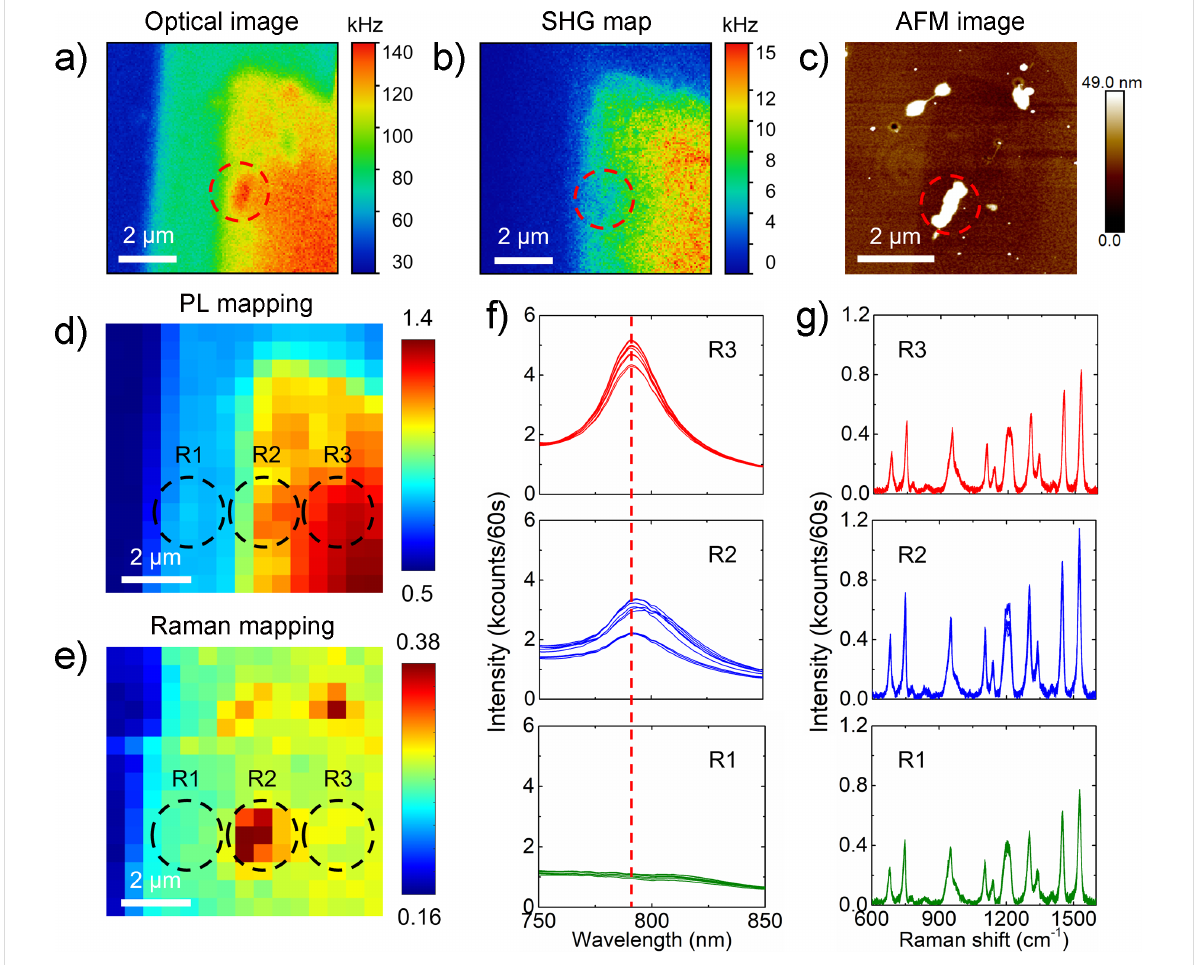
Figure 2: The local structure-related optical properties of CuPc/MoSe 2 . (a) Linear optical image of CuPc/MoSe 2 with a scan area of 8 × 8 μ m. Raman and photoluminescence signals are collected simultaneously in the linear optical images. (b) SHG map of the corresponding region of CuPc/MoSe 2 . (c) AFM topographic image of the corresponding region of CuPc/MoSe 2 . (d) Photoluminescence mapping image of the corresponding region of the photoluminescence peak from MoSe 2 at 790 nm. (e) Raman mapping image of the corresponding region of CuPc Raman peak at 1527 cm − 1 . The color bars in (d) and (e) indicate the integrated optical intensity. The linear optical image and photoluminescence (Raman) mapping images are con- ducted using azimuthal polarization. (f) Photoluminescence spectra and (g) Raman spectra collected from three different regions (R1, R2, and R3) of the CuPc/MoSe 2